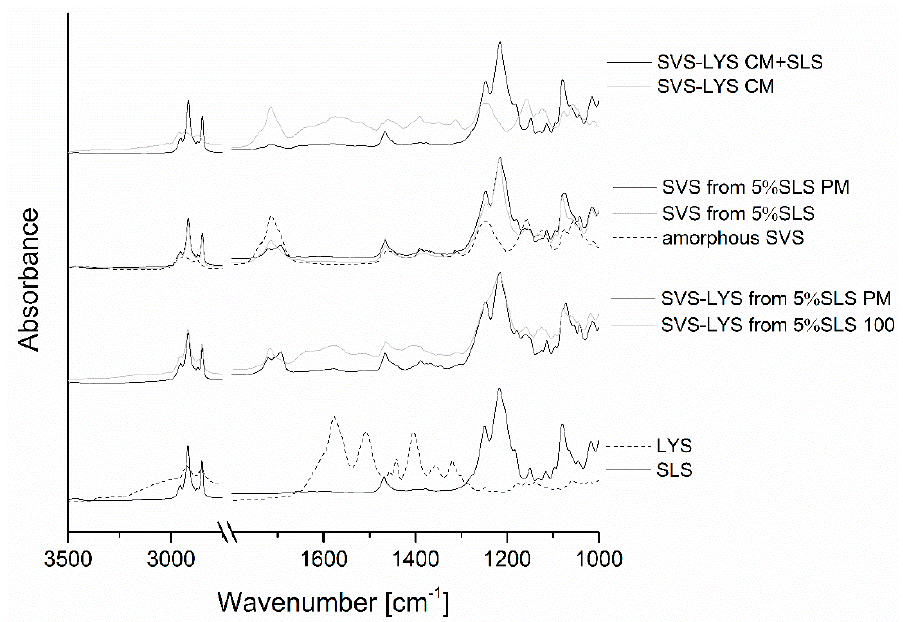
Figure 4. FTIR spectra of the prepared samples and corresponding physical mixtures (PMs). In addition, the spectra of amorphous SVS (prepared by CM) and SVS-LYS CM are shown for comparison.